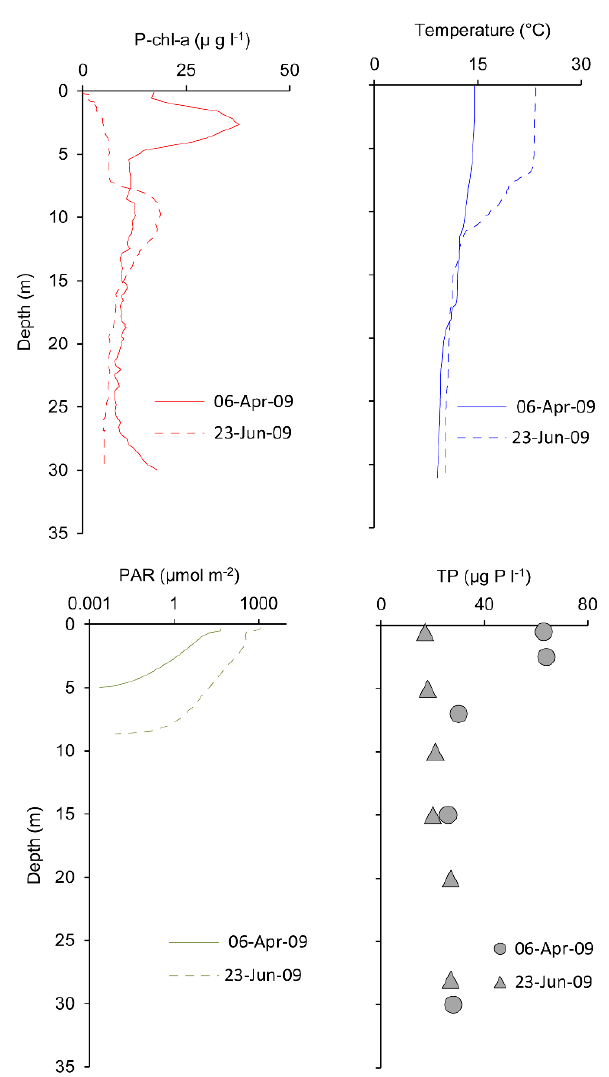
Figure 2. Profiles of temperature, PAR (logarithmic scale), P-chl-a and TP measured at station St6 on 6 April 2009 and 23 June 2009. In June, the P-chl-a peak moved deeper, forming a clear deep chlorophyll maximum [30] located within a well-established thermocline between 7 and 16 m depth. Maximum P-chl-a values of 19 µg L − 1 (T-chl-a = 21 µg L − 1 ) were recorded at 9.5 m, where temperatures of about 16 ◦ C were measured. The chlorophyll-a maximum was centered below the nominal depth of the euphotic zone located at around 5 m (residual PAR of 11 µ mol m 2 s − 1 ). At 7 m, the incident PAR was close to 1 µ mol m 2 s − 1 , while below 8 m, the PAR signal was no longer detectable. TP concentrations were between 17 (surface) and 27 (bottom) µ g P L − 1 , but, unlike April, they did not show any increase in the proximity of the chlorophyll-a peak. DRP concentrations increased slightly at around 4–5 µ g P L − 1 (Table 2), possibly indicating a decrease in the phosphorus uptake by the P. rubescens